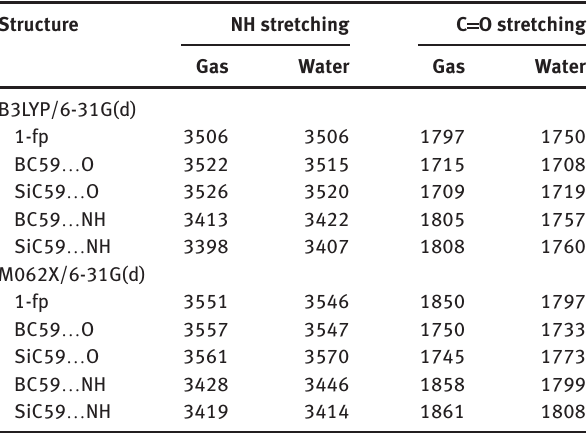
Table 4: NH and C = O stretching frequencies for the studied